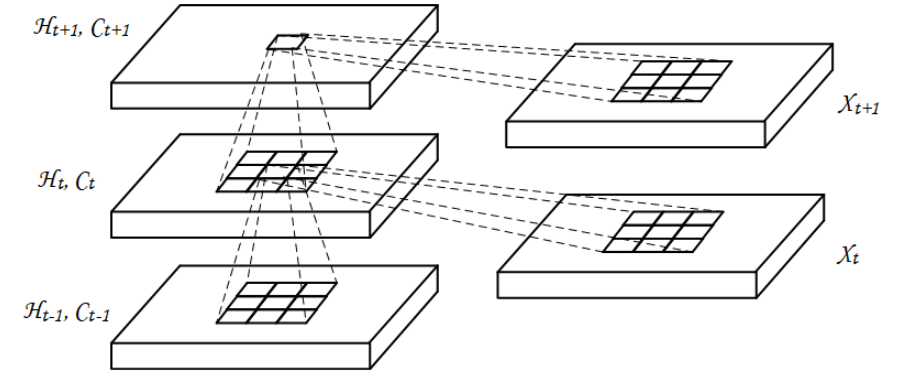
Figure 3. Inner structure of ConvLSTM.